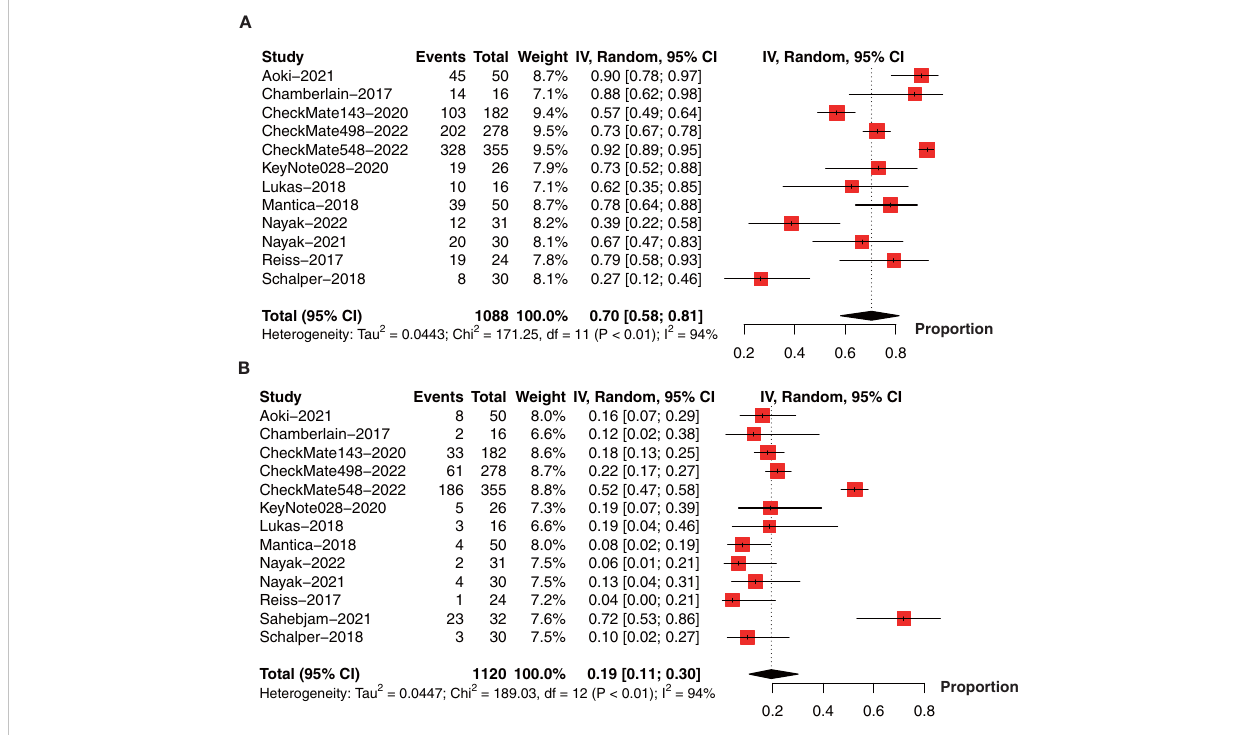
FIGURE 8 Forest plot showing the incidence of anti-PD-1/PD-L1-related (A) AEs and (B) AEs ≥ grade 3 in glioma. AEs, adverse